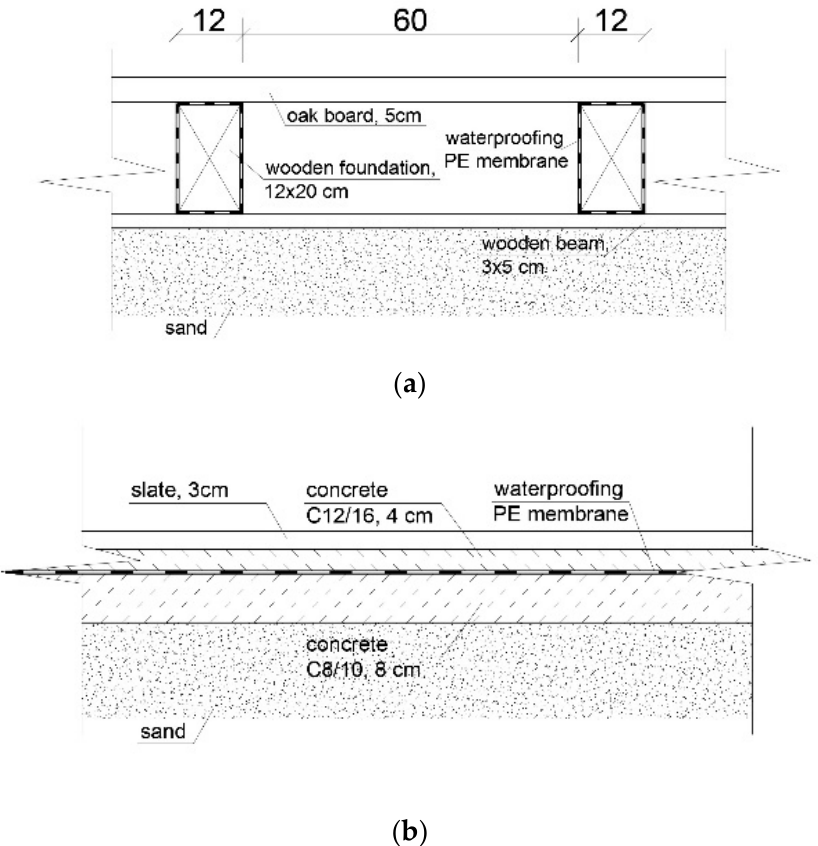
Figure 5. Material and construction solutions for the floor included in the analysis: ( a ) wooden floor; ( b ) stone floor.